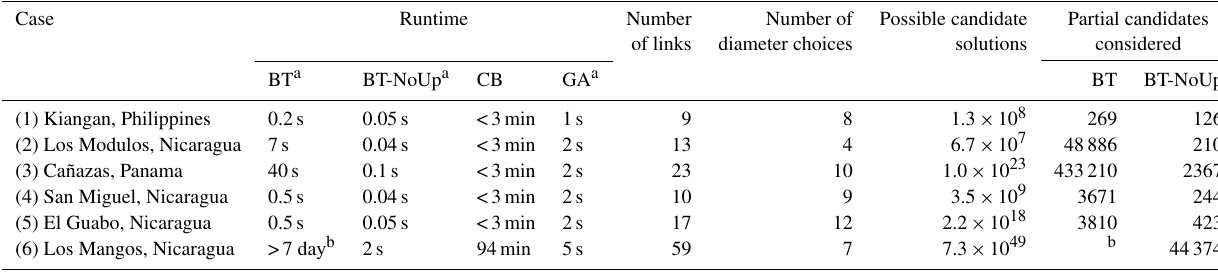
Table 3. Runtime and size of solution space for each algorithm. Case